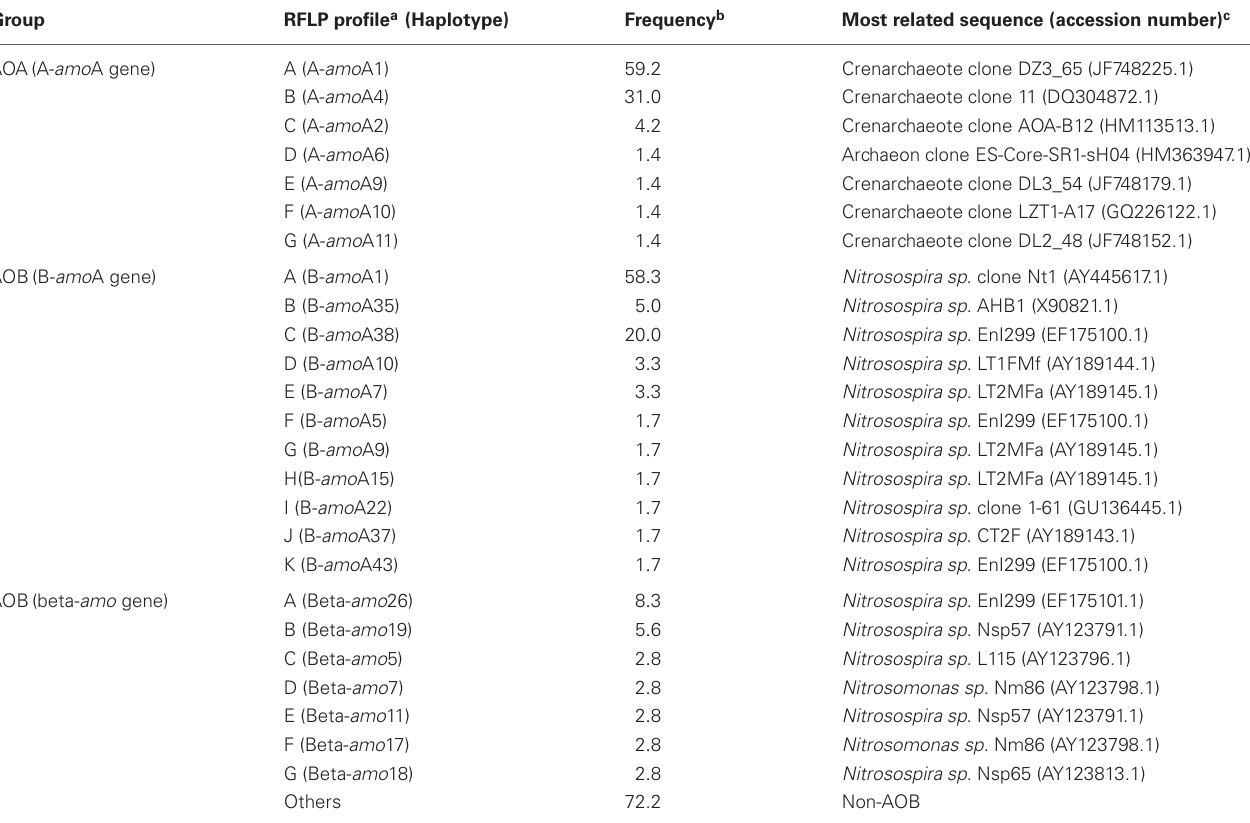
Table 2 | Relative frequency of haplotypes in the AOA and AOB gene libraries.